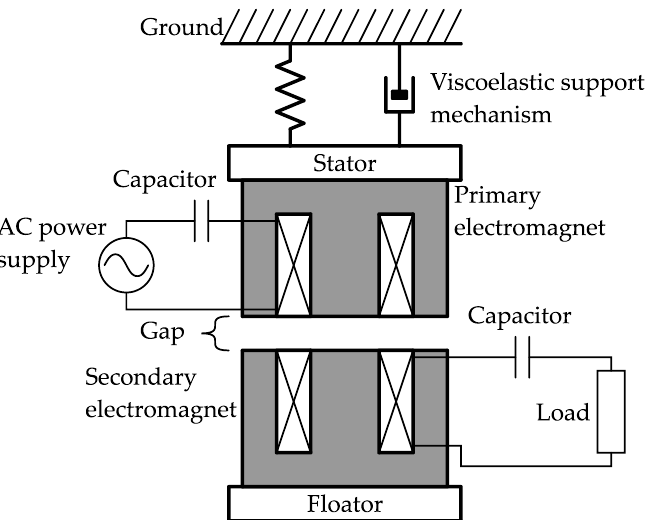
Figure 7. Basic configuration of AC magnetic suspension with a power transmission by a magnetic resonant coupling. The upper electromagnet corresponds to the primary electromagnet, and the lower electromagnet corresponds to the secondary electromagnet. The load consumes transmission power.